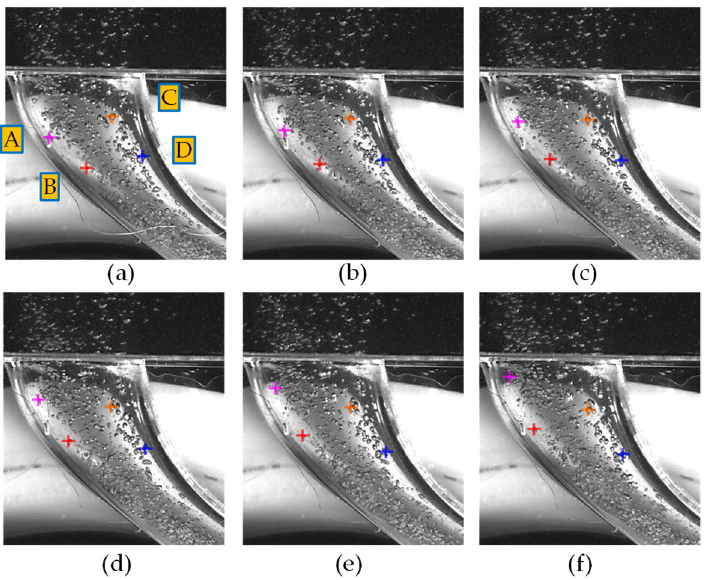
Figure 11. Bubble tracking at the volute diffuser. ( a ) 9.587 s, ( b ) 9.587 s + Δ t, ( c ) 9.587 s + 2 Δ t, ( d ) 9.587 s + 3 Δ t, ( e ) 9.587 s + 4 Δ t, and ( f ) 9.587 s + 5 Δ